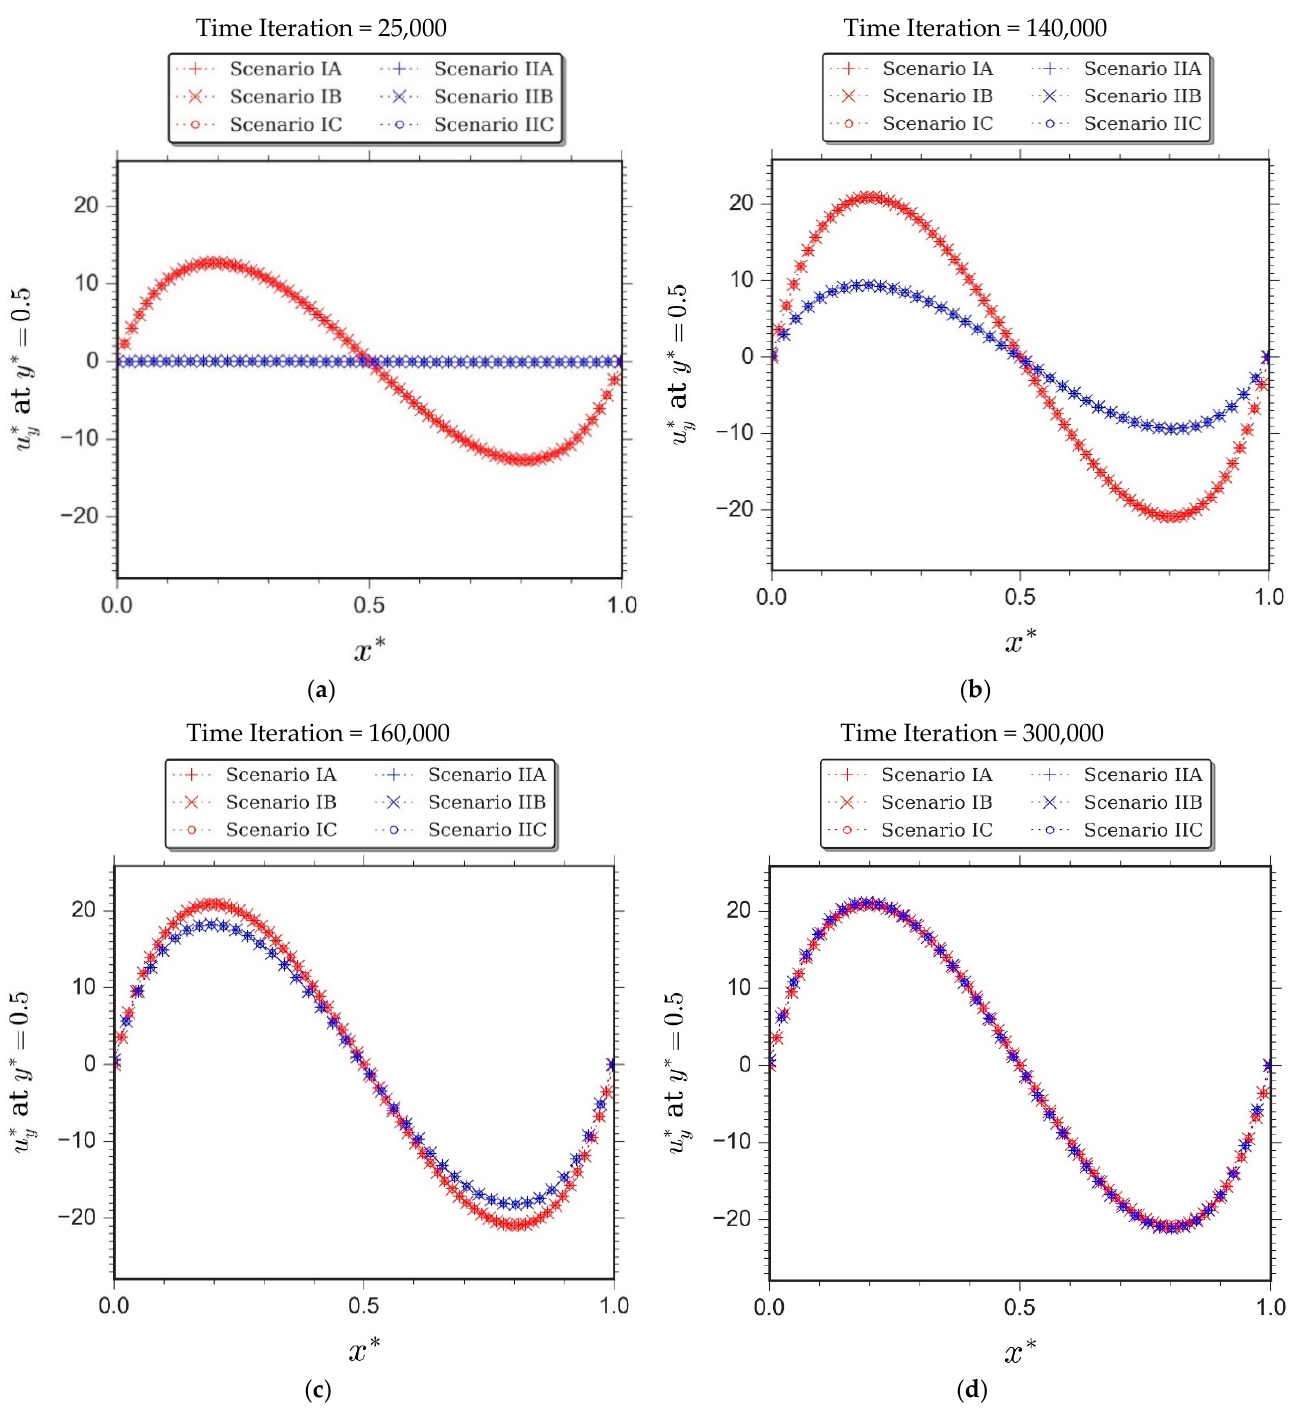
Figure 8. Profiles of average Nusselt number at the hot wall ⟨ Nu ⟩ 0 from different LBM scenarios during the unsteady period up to the accomplishment of steady-state condition of the Rayleigh-Bènard convection for aspect ratio = 1, Ra = 10 4 , Pr = 0.71 , τ υ = 0.6 , and Ma = 0.1 , showing computational behaviour with ( a ) dimensional simulation time t as the horizontal axis and ( b ) dimensionless simulation time t * as the horizontal axis. Figure insets display the magnification of the computational characteristics in the steady-state region of the simulation.